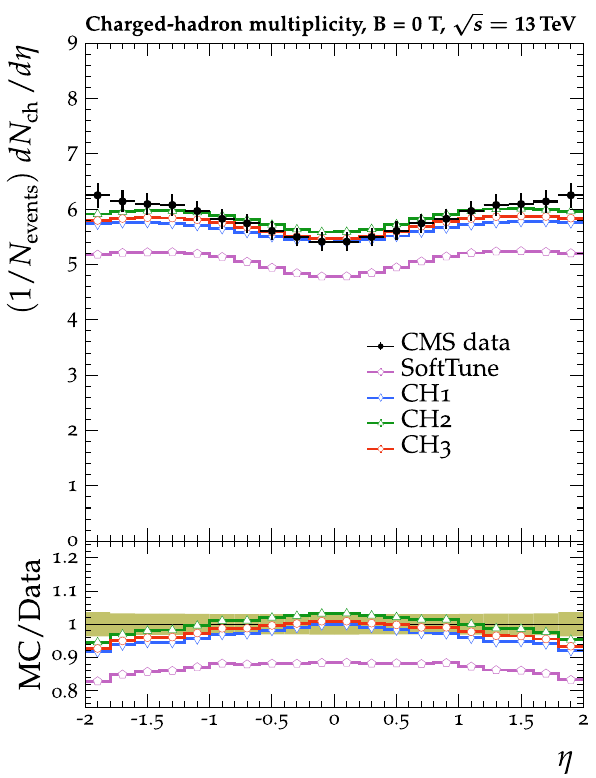
Fig. 2 The normalized d N ch / d η of charged hadrons as a function of η [27]. CMS MB data are compared with SoftTune and the CH tunes. The coloured band in the ratio plot represents the total experimental uncertainty in the data. The vertical bars on the points for the different predictions represent the statistical uncertainties respectively. Data that have been categorized in this way are referred to as UE data in this